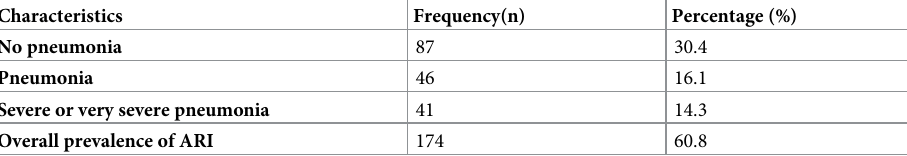
Table 1. Prevalence of ARI. n =